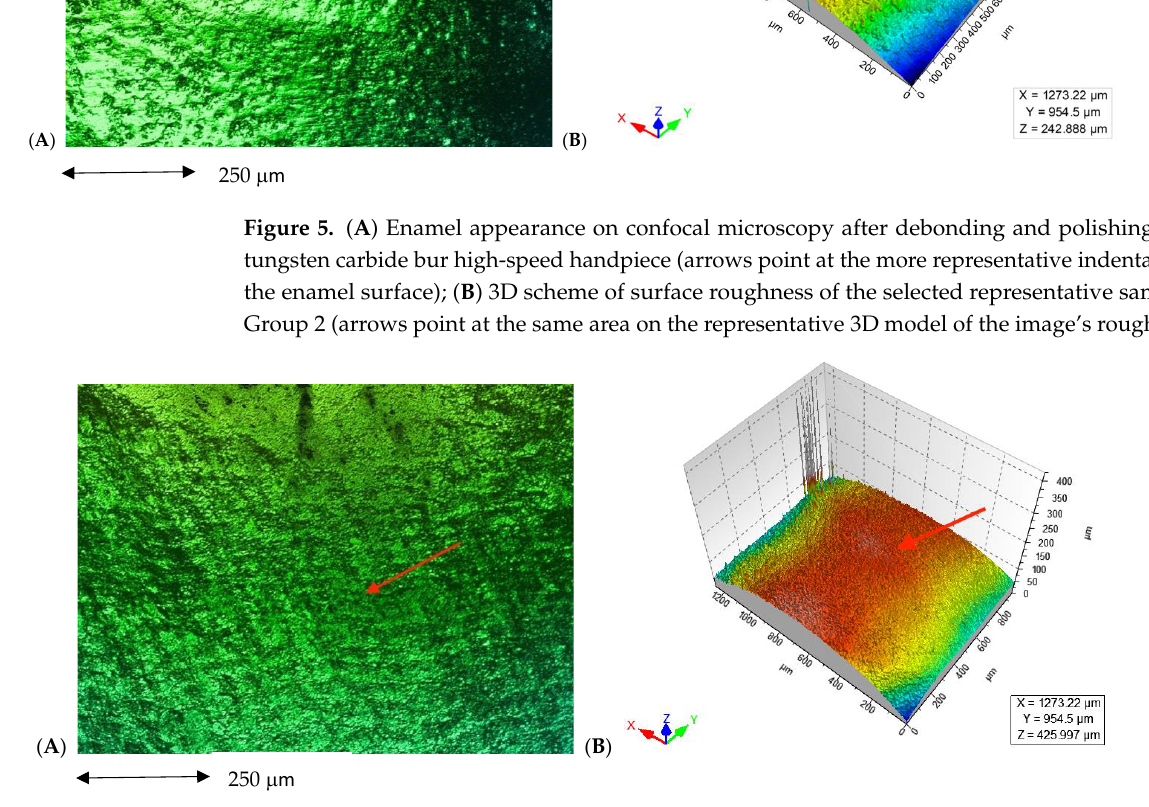
Figure 7. Representative image of enamel of a Group 1 sample after polishing with a white stone bur at a high speed (arrow points at the most evident indentation of the bur on the enamel surface).